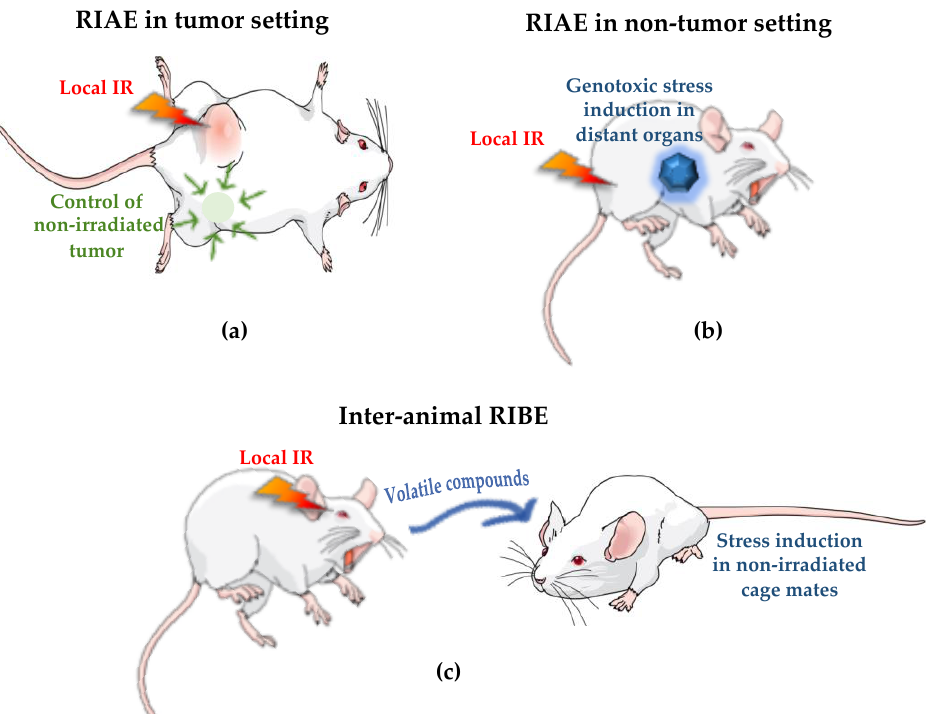
Figure 4. Non-targeted effects in animals that can be generated at synchrotron facilities. RIAE within the same organism in tumor ( a ) and non-tumor settings ( b ) display different systemic effects mediated by the immune system. RIAE can be both beneficial ( a ) or genotoxic ( b ). ( c ) Detrimental or beneficial non-targeted effects mediated by volatile factors can occur in another bystander organism(s) sharing an environment with irradiated animals (see Section 5.2.2).